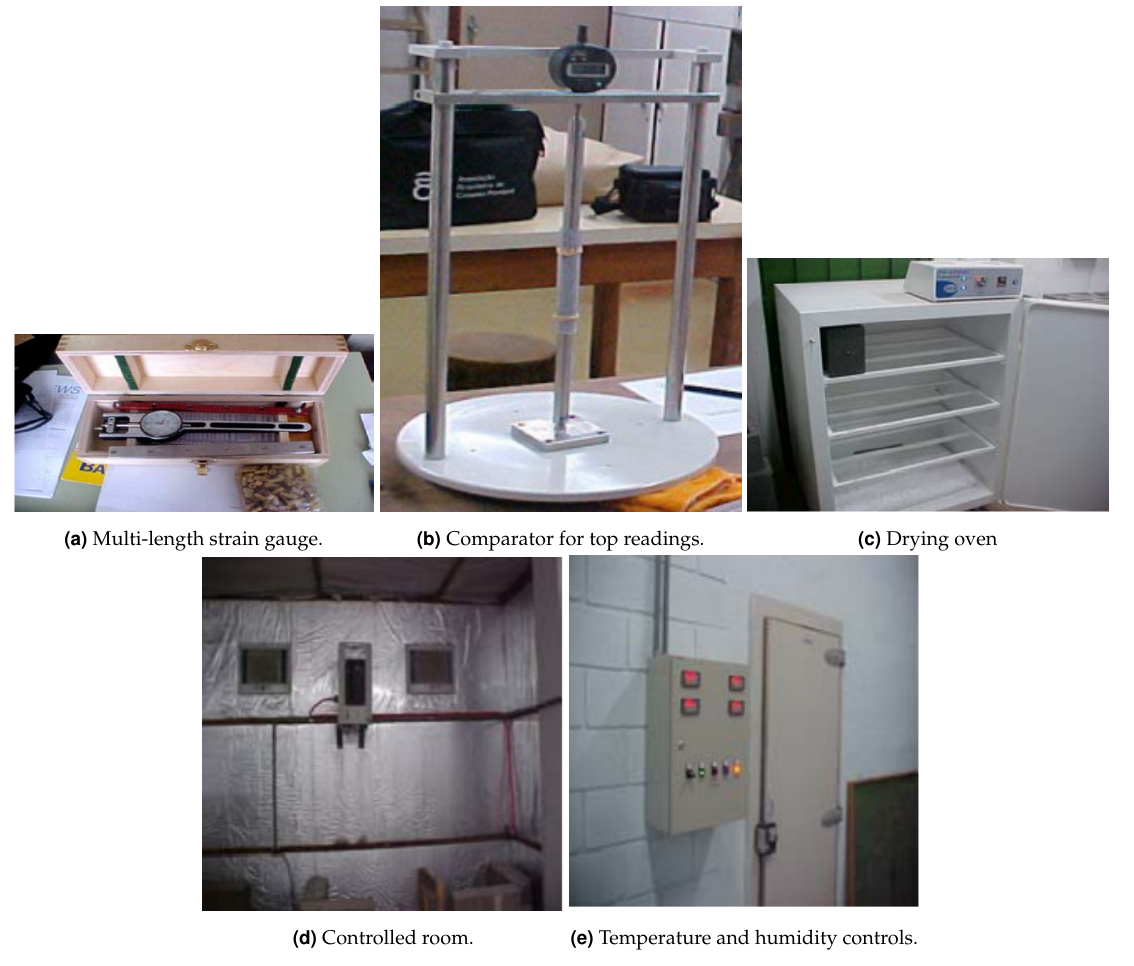
Fig. 1. Experimental set-up for drying shrinkage of